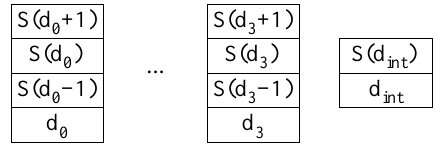
Figure 4: Definition of 18 data elements that need to be stored for each pixel in the eSGM